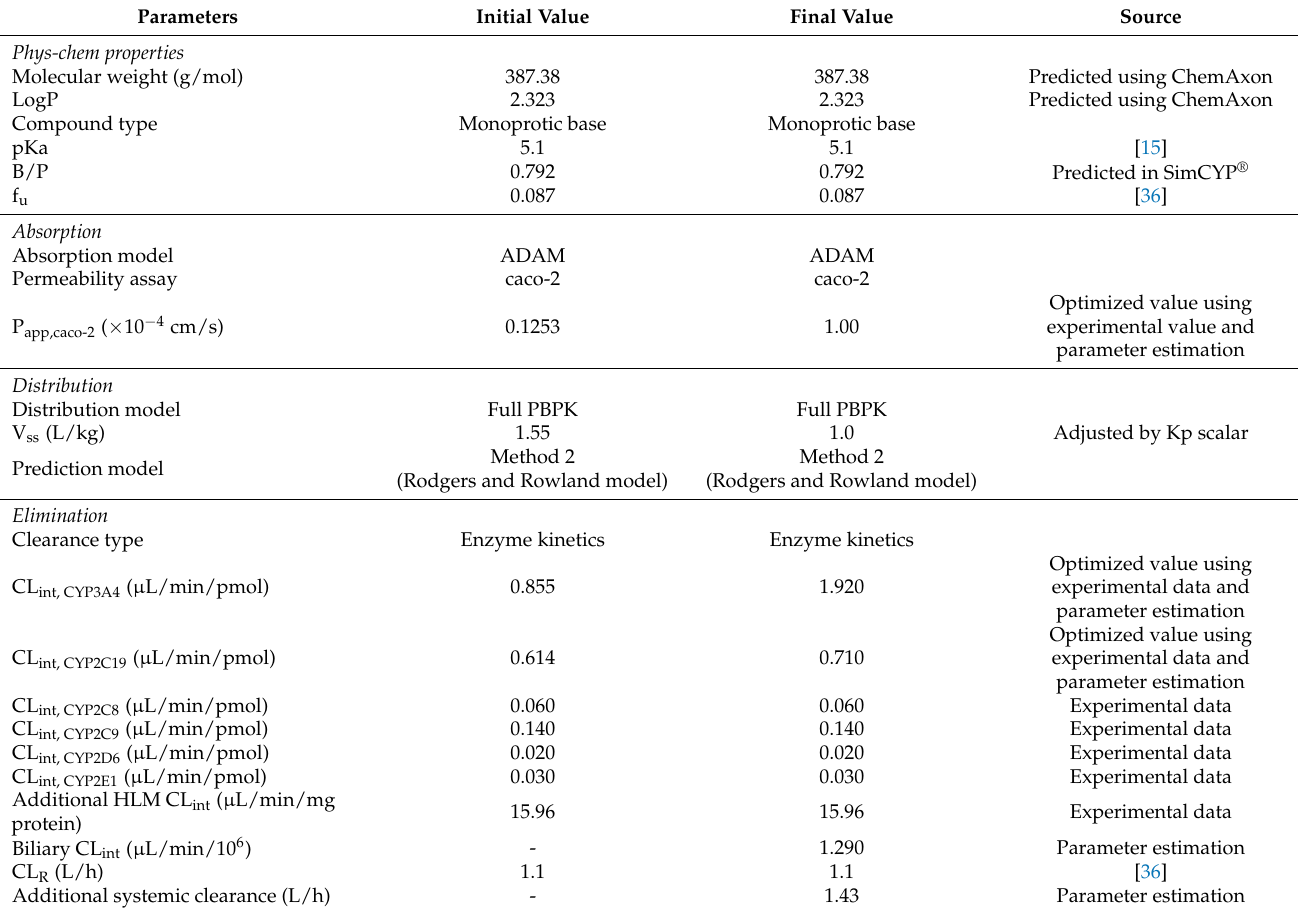
Table 1. The input parameters for the tegoprazan PBPK